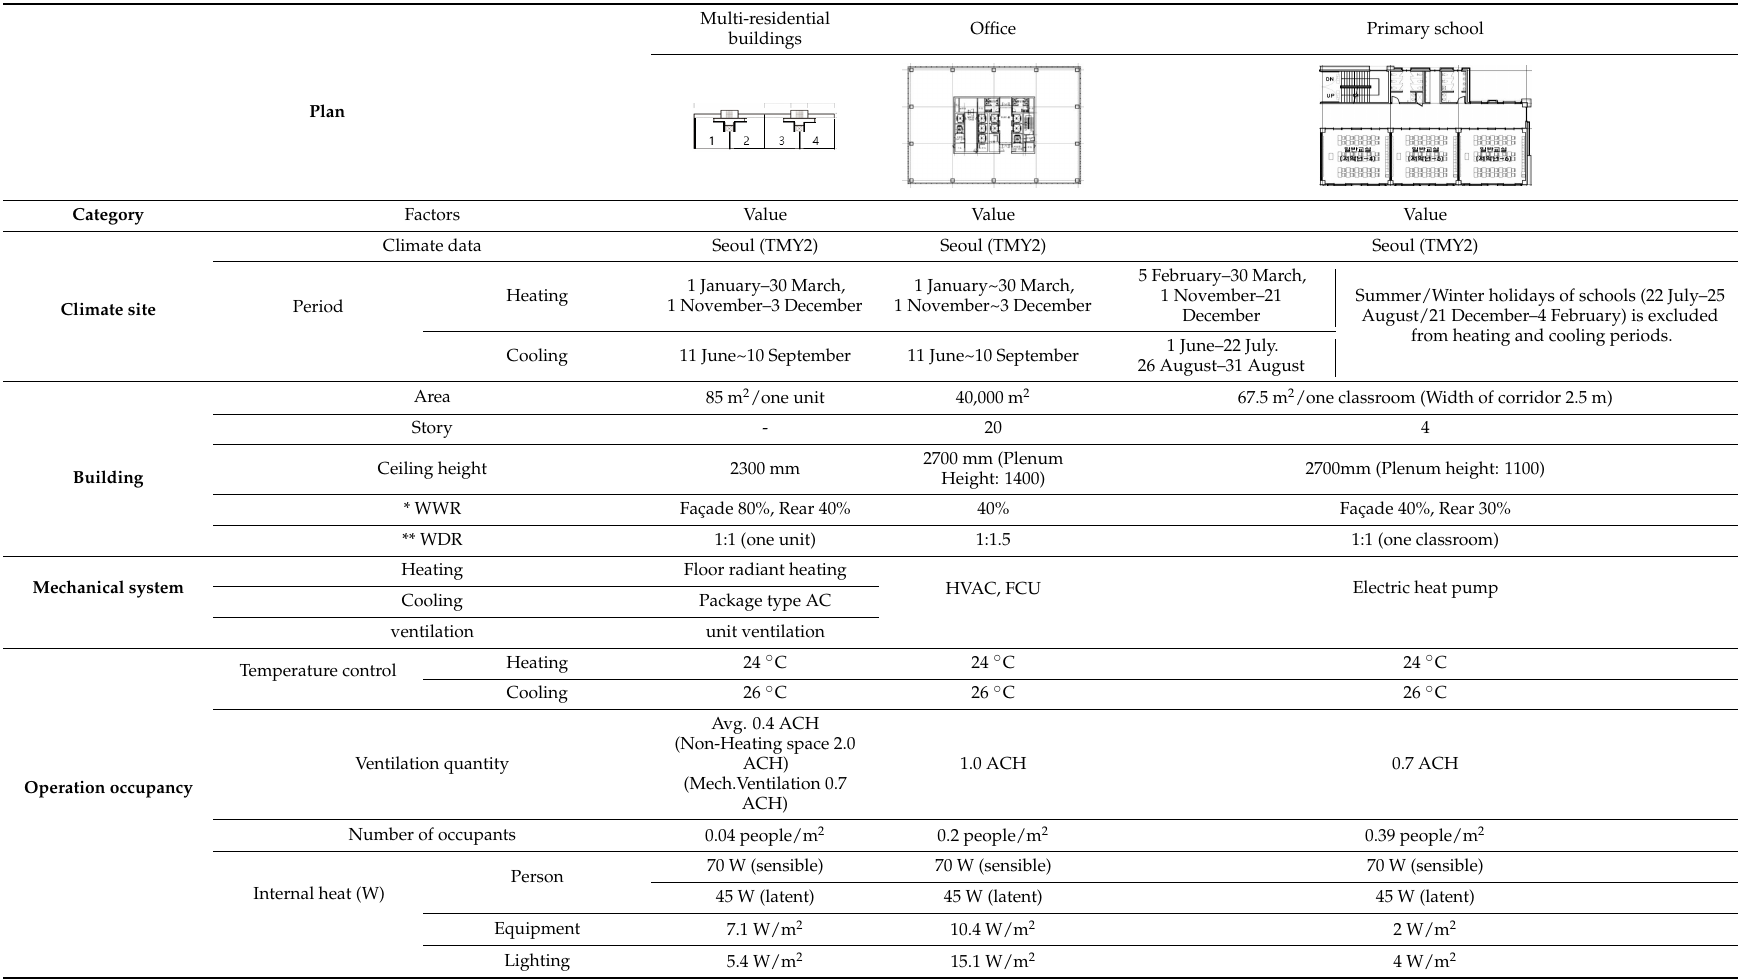
Table 1. Brief description of baseline model. HVAC: heating, ventilating, and air conditioning; TMY2: typical meteorological year version 2.